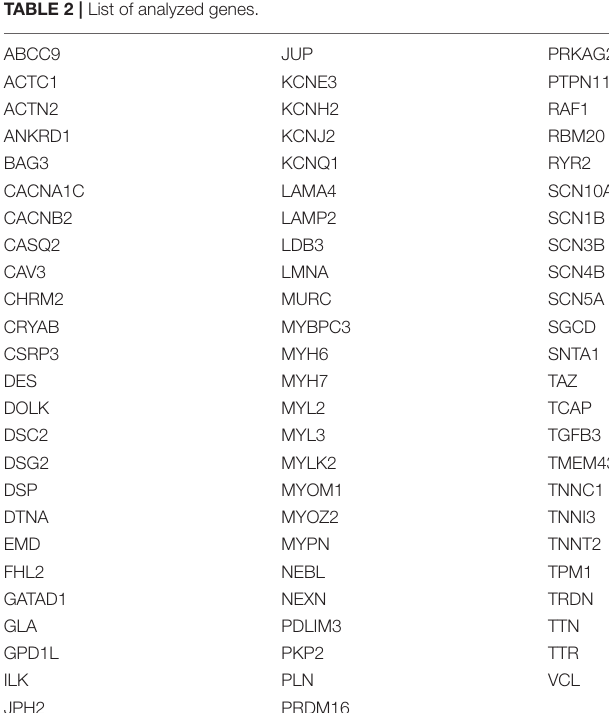
TABLE 2 | List of analyzed